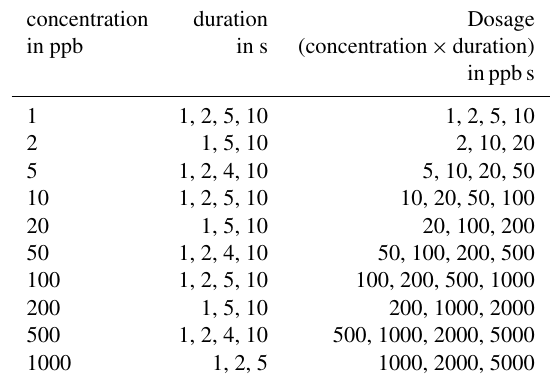
Table 1. Concentration and duration combinations for ethanol peaks.